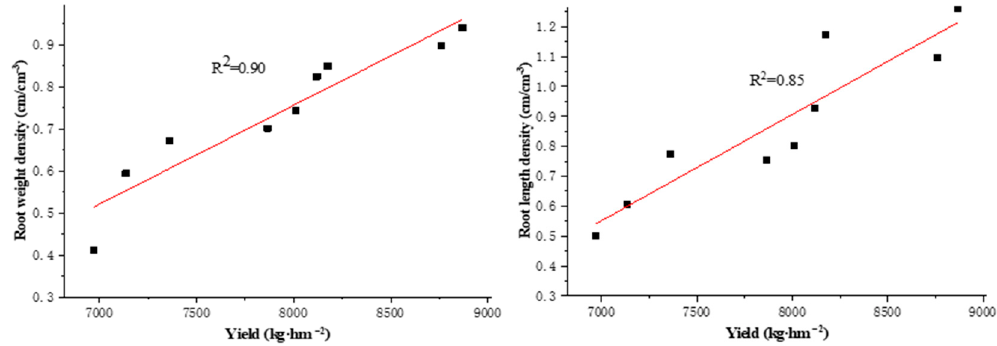
Figure 5. The relationship between yield and root weight density and root length density.